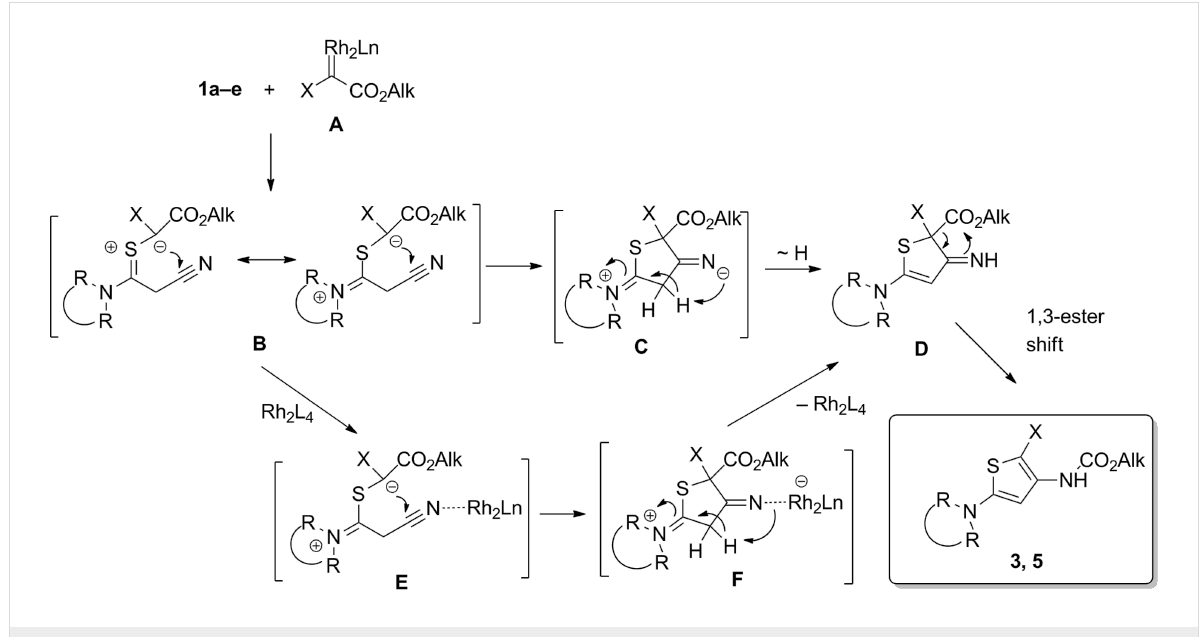
Scheme 4: The assumed mechanism for the formation of thiophenes 3 , 5 .